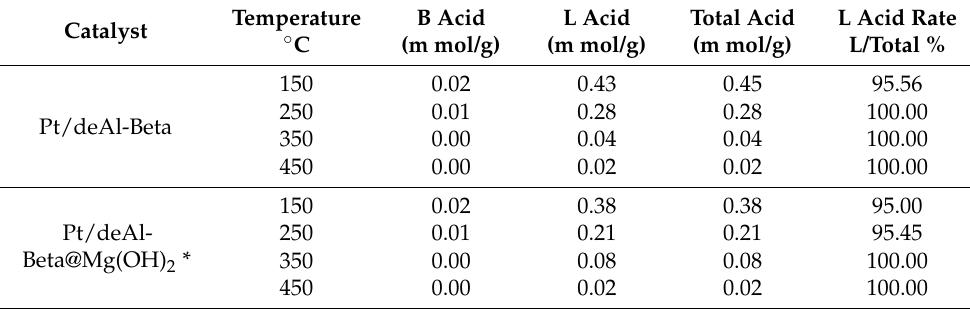
Table 1. The acid sites of Pt/deAl-Beta and Pt/deAl-Beta@Mg(OH) 2 catalysts. Temperature Catalyst ◦